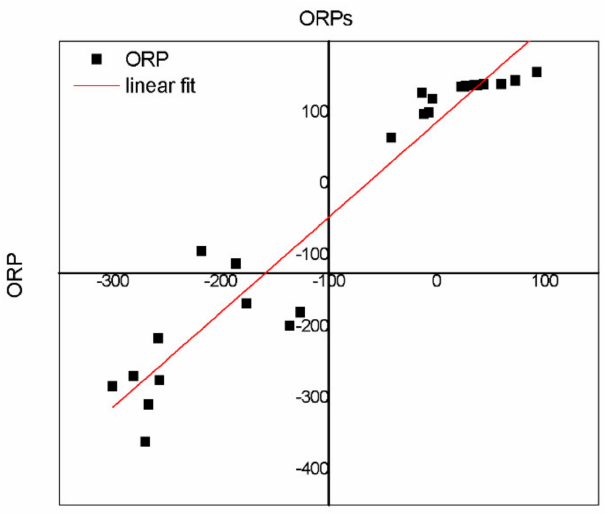
Figure 10. Denitrification plotted ORP data vs. ORP simulated and linear-fit